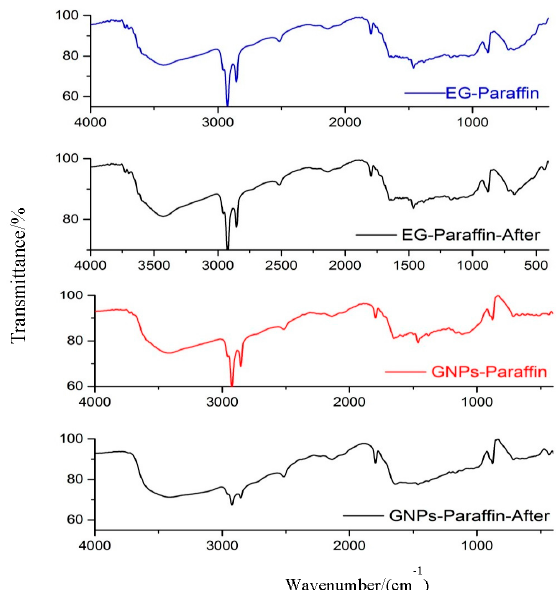
Figure 9. FT-IR of composite PCMs before and after thermal cycling.